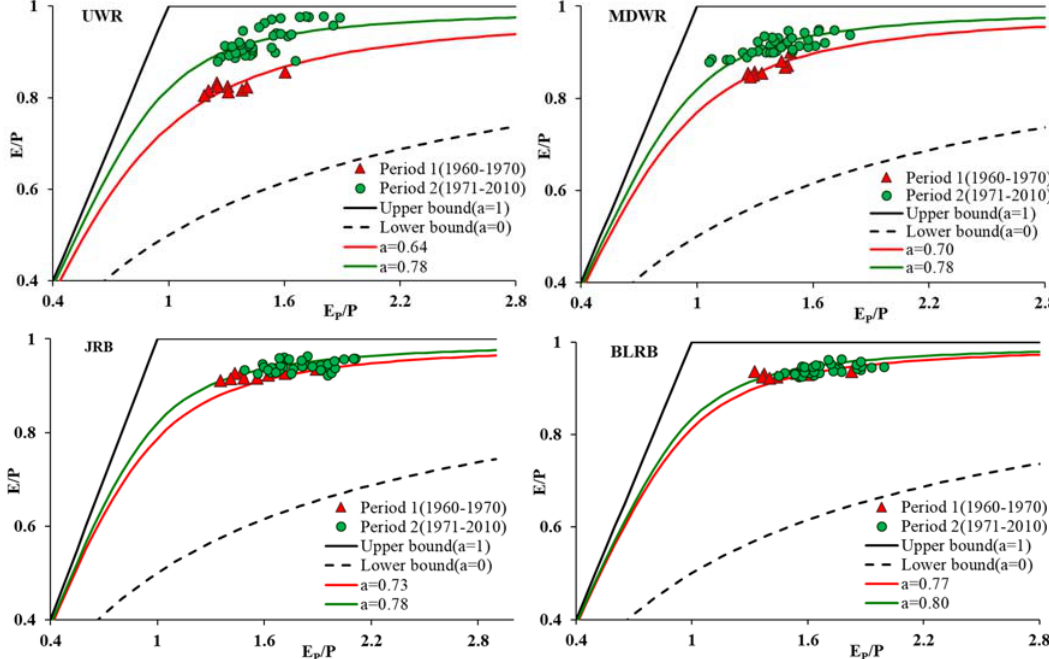
Figure 7. The trajectory of evaporation ratio versus aridity index from period 1 (pre-change period) to period 2 (post-change period) in the four sub-catchments of WRB. The red solid lines and green solid lines indicate the fitted Budyko curves before and after breakpoints, respectively.